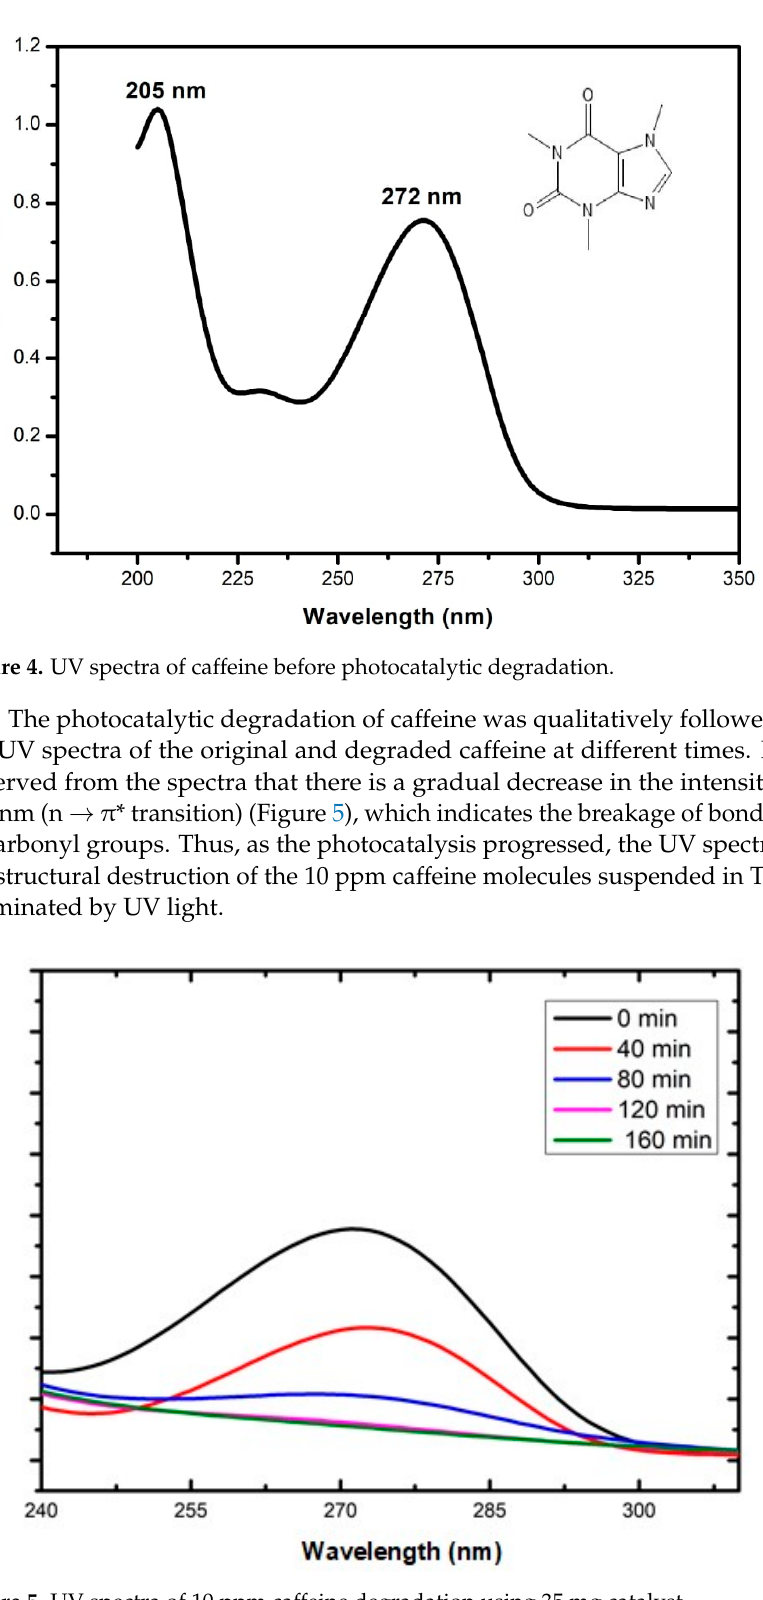
Figure 5. UV spectra of 10 ppm ca ff eine degradation using 35 mg catalyst.